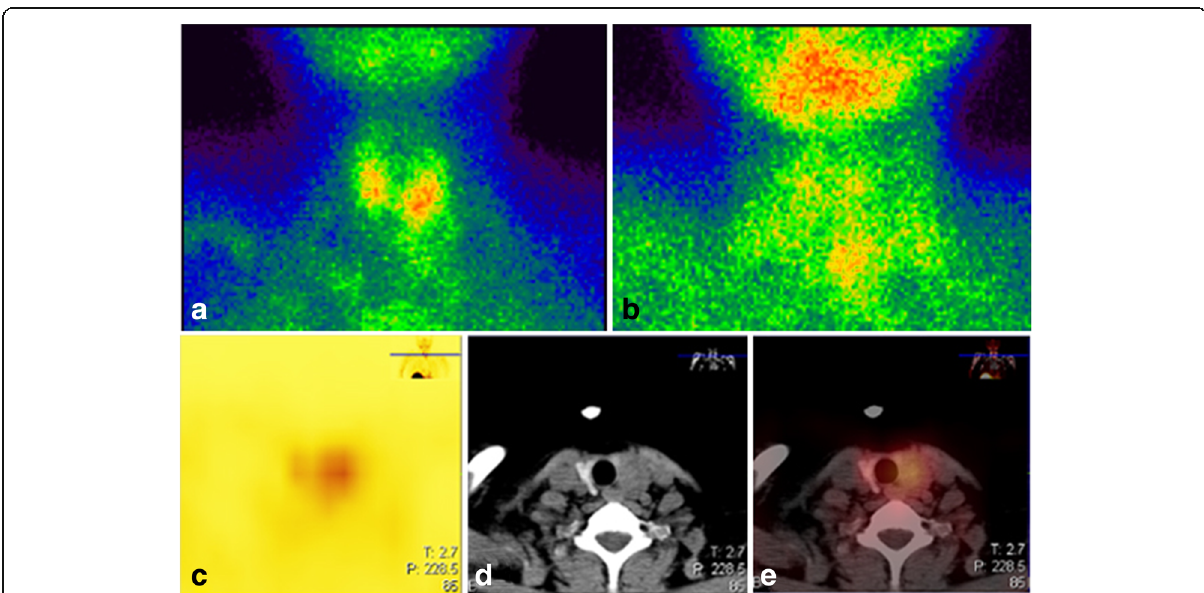
Fig. 1 Representative 99m Tc-MIBI thyroid images indicative of hyperparathyroidism. The patient was intravenously injected with 740 – 925 MBq 99m Tc-MIBI. A single-photon emission (SPECT)/CT instrument was used, which was equipped with a parallel low-energy high-resolution collimator with an energy peak of 140 keV and a window width of 20%. The magnification when performing the neck scan was 1.5-fold, with a matrix of 128×128 pixels and an acquisition count of 1000 K at 10 min and an acquisition count of 682 K at 120 min 99m Tc-MIBI injection. Two points have the same acquisition time of